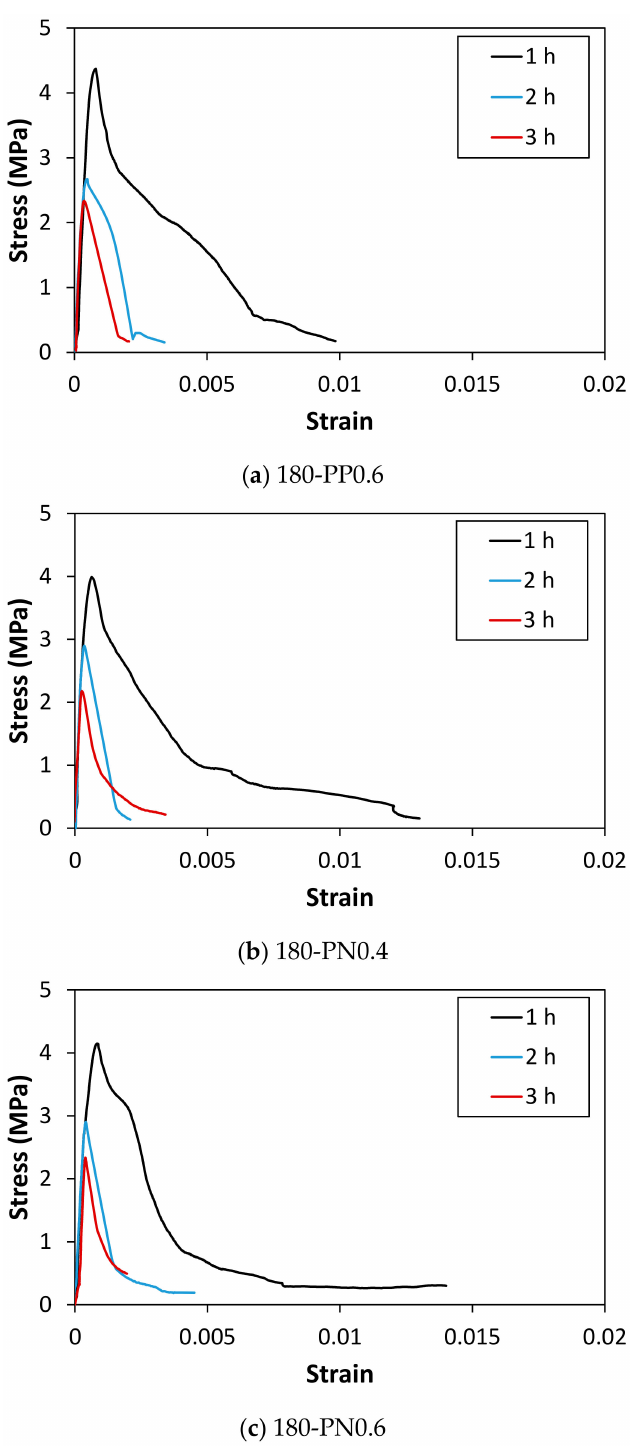
Figure 7. Residual stress–strain curves of specimens with a strength of 180 MPa according to the exposure